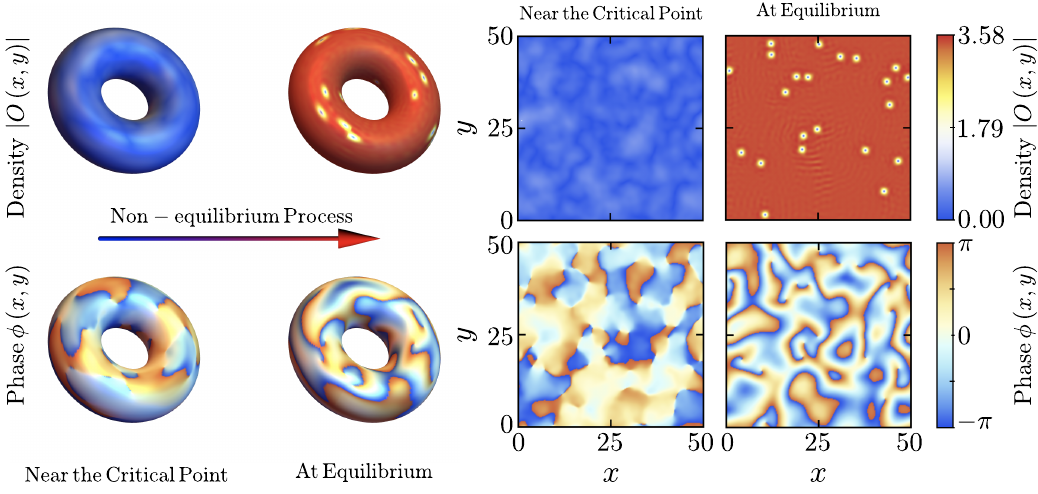
Figure 1 . (Top) Phase of the superconductor after the thermal quench. After the non-equilibrium dynamics, the phase in the top panel will evolve into the bottom panel (phase ordering). Now it is hard to see the “domain structure” like the bottom panel. There will be a branch cut connecting two defects if the phase geometry is a closed space. (Bottom) Phase of the order parameter near the critical point. The domain structures of the phase space are shown. Among them, there are singular points (topological defects) where vortices will eventually